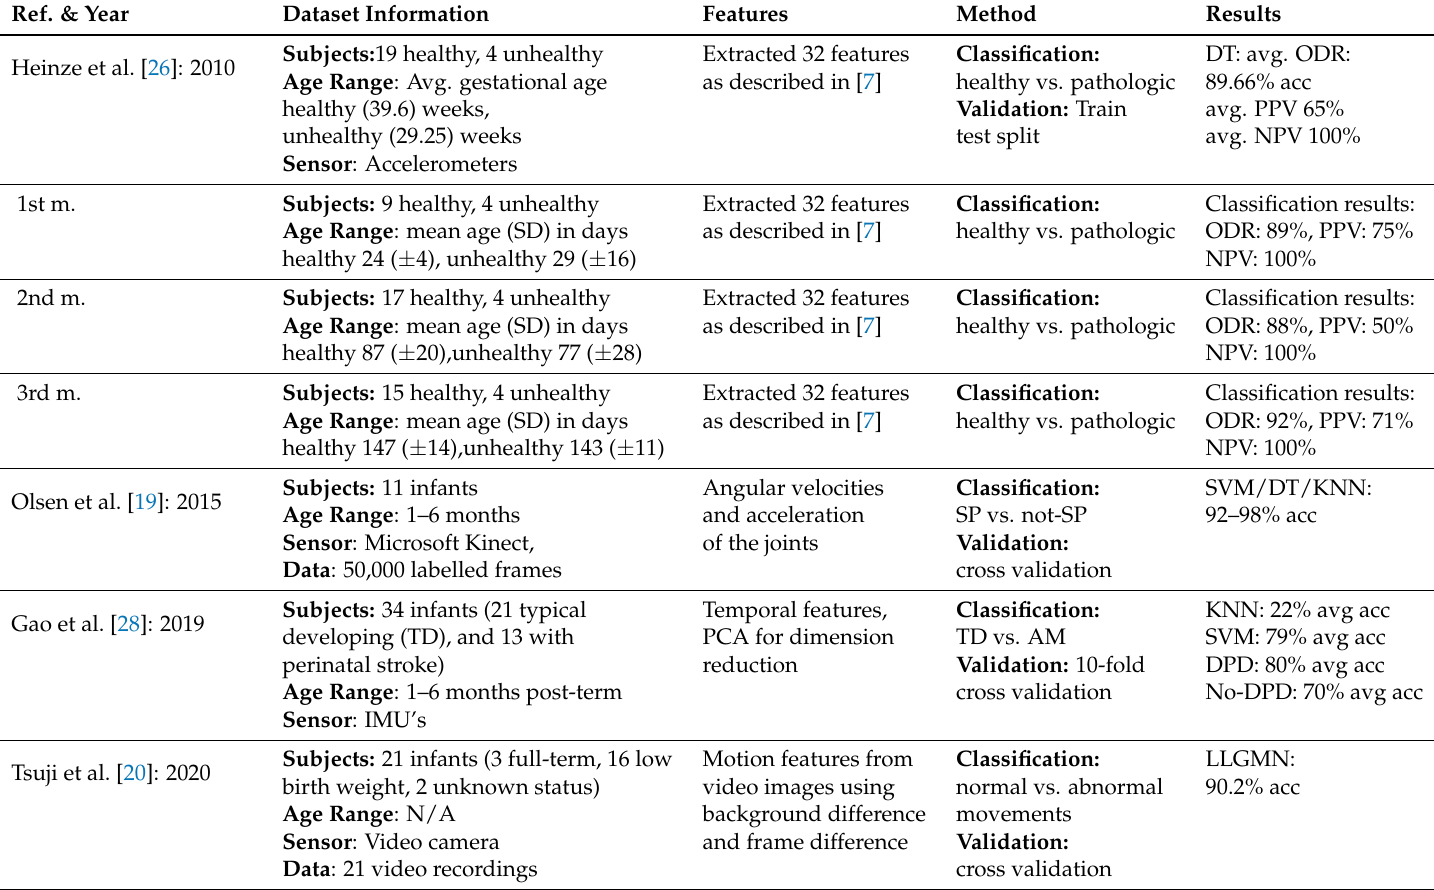
Table 6. Classification results of general movement (GMs) and fidgety movement (FMs)